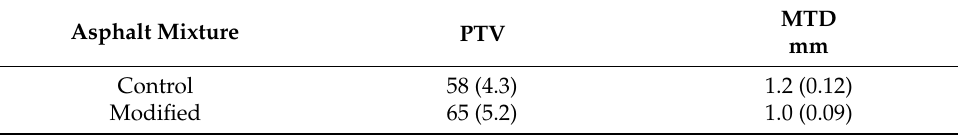
Table 4. Surface characteristics of the control and modified SMA